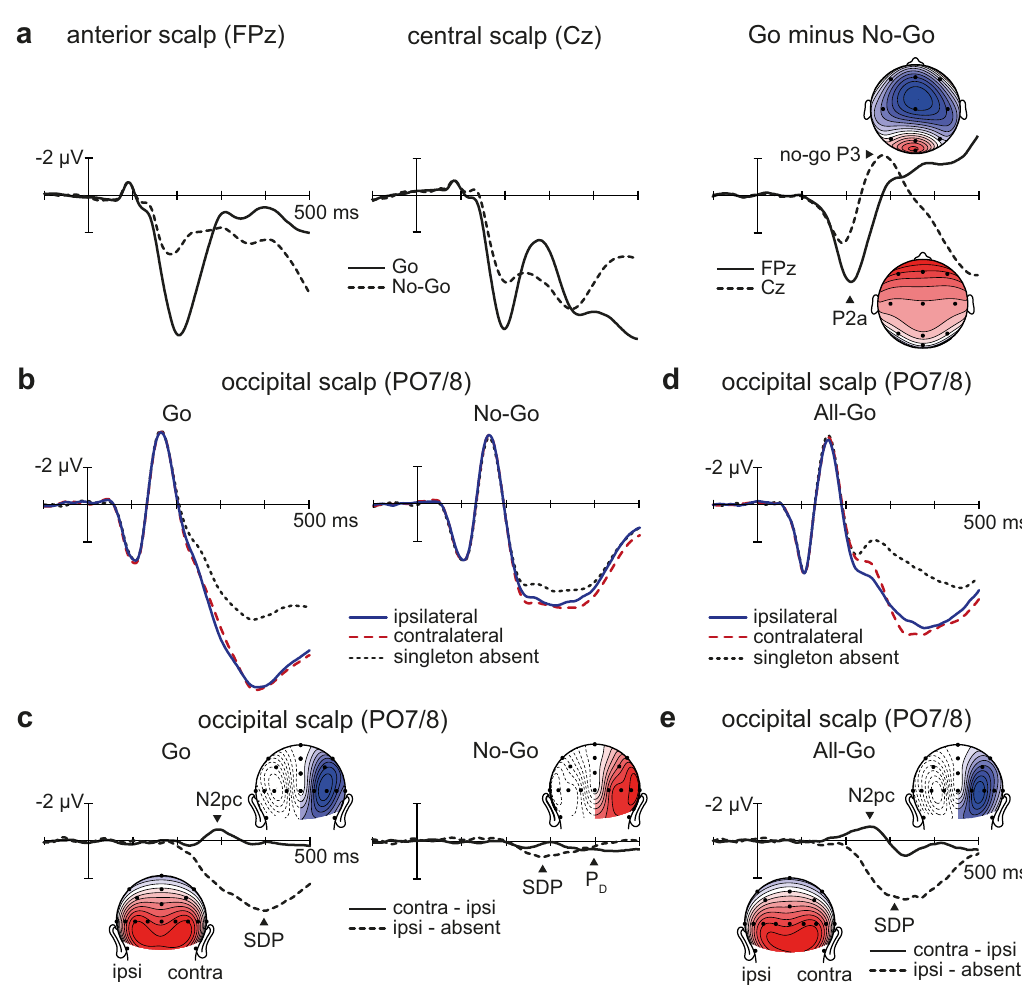
Fig 2. Grand-averaged ERP results from Experiments 1 and 2. AU : AbbreviationlisthasbeencompiledforthoseusedinFigs 2 to 4 : Pleaseverifythatallentriesarecorrect : Negative voltages are plotted upwards by convention. The underlying data supporting this figure can be found at https://osf.io/4wdzq. ( a ) Go and No-Go ERPs and associated Go-minus- No-Go difference waveforms from Experiment 1, plotted at frontal (FPz) and central (Cz) scalp sites. ( b ) Occipital ERPs plotted separately for Go and No-Go trials of Experiment 1. ( c ) Difference waveforms over the occipital scalp from Experiment 1. ( d ) All-Go ERPs over the occipital scalp from Experiment 2. ( e ) Difference waveforms over the occipital scalp from Experiment 2. ERP, event-related potential.